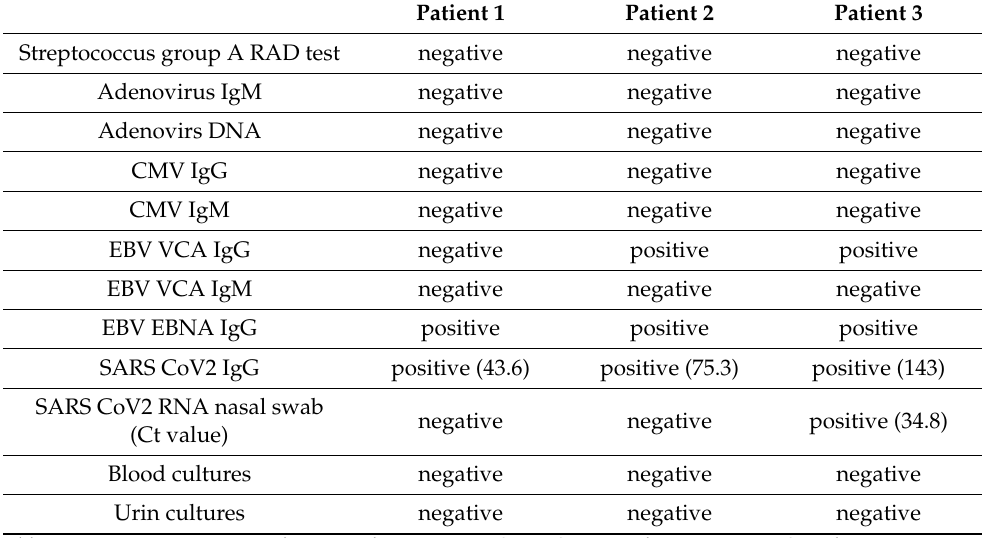
Table 3. Serology, bacterial, and viral results.